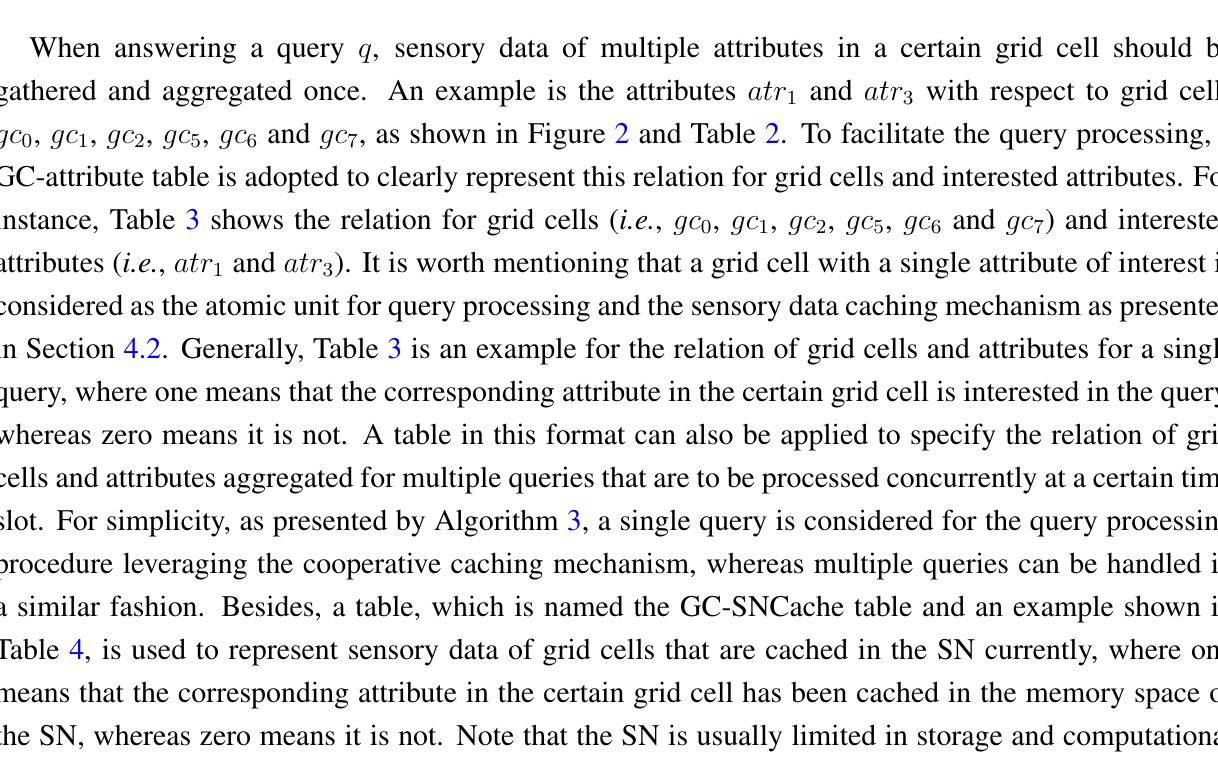
i ) is interested 3